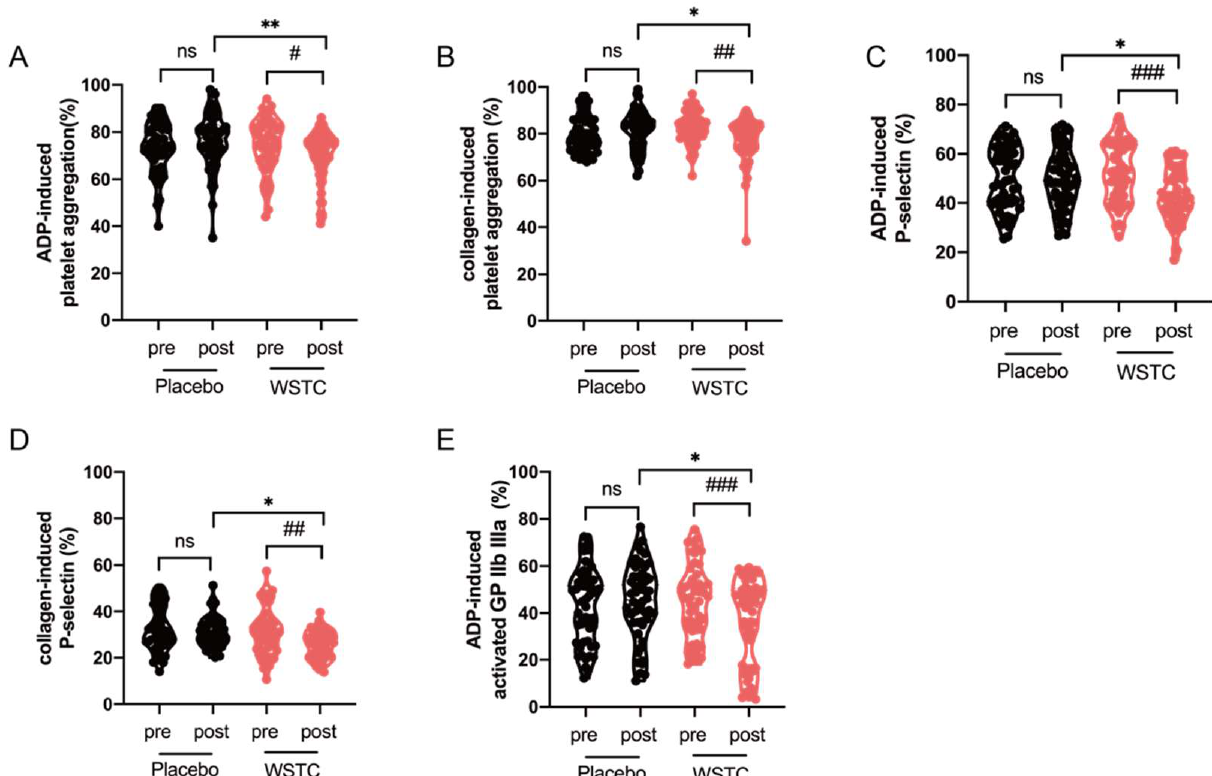
Figure 6. WSTC supplementation inhibited platelet aggregation and activation in healthy middle- aged and elderly adults. Human PRP was prepared from volunteers before (pre) and after (post) 4 weeks of WSTC or placebo consumption. ( A , B ) Platelet aggregation was stimulated by ADP or col- lagen. PRP was stimulated with ADP or collagen. The platelet surface expression of ( C , D ) P-selectin and ( E ) PAC-1 was analyzed by flow cytometry. The values are presented as the means ± SEMs. At baseline, there was no significant difference for platelet aggregation and activation between the two groups. * p < 0.05 and ** p < 0.01, one-way analysis of variance for independent data was used for a comparison between the two groups after 4 weeks of intervention. # p < 0.05, ## p < 0.01 and ### p < 0.001 vs. baseline in the WSTC group, assessed by a paired Student’s t -test. Abbreviations: PRP, platelet-rich plasma and WSTC, water-soluble tomato concentrate.